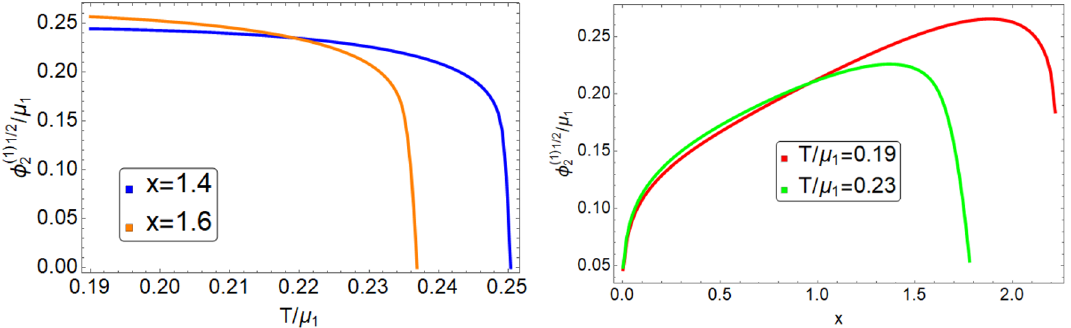
Figure 5 . The order parameter φ (1)